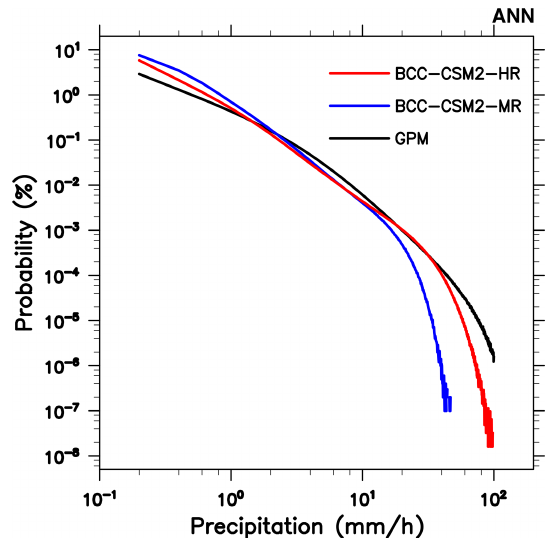
Figure 9. The probability density of 3-hourly precipitation between 40 ◦ S and 40 ◦ N and during the period from 2001 to 2014, as a function of precipitation intensity with intervals of 1mmh − 1 , for IMERG precipitation (black line), BCC-CSM2-MR (blue line), and BCC-CSM2-HR (red line). The two simulations were re-gridded to the grid of IMERG before